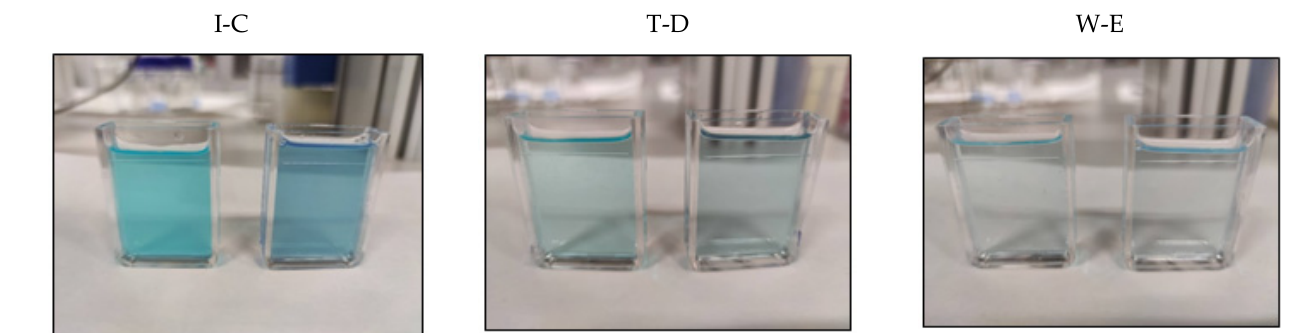
Figure 1. Photographs showing a vivid presentation of the commercial beverages (on the left of each pair) and the beverages containing the C-PC extract as a natural colourant (on the right of each pair). Three representative samples are shown: I-C representing isotonic beverages, T-D representing tonic beverages, and W-E representing wine.